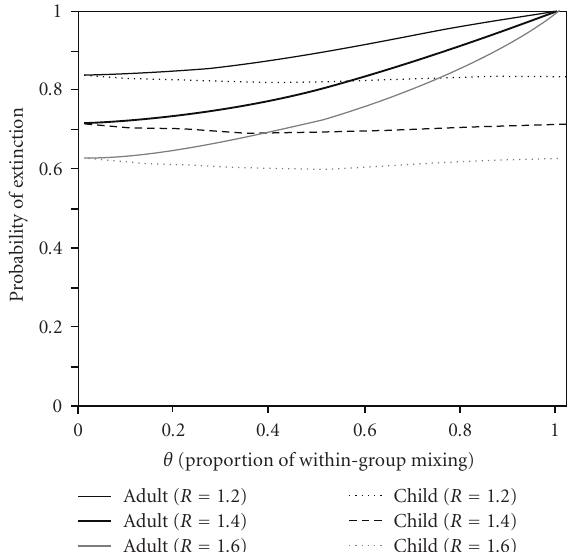
Figure 4: Assortativity and the probability of extinction. The probability of extinction in a fully susceptible population given a single adult or child index case is measured as a function of θ , the proportion of within-group mixing. The next-generation matrix, parameterized by Fraser et al. [6] with the dominant eigenvalue R 0 = 1 . 58, is rescaled by multiplying each entry with R/R 0 where R is set to be 1.2, 1.4 and 1.6,